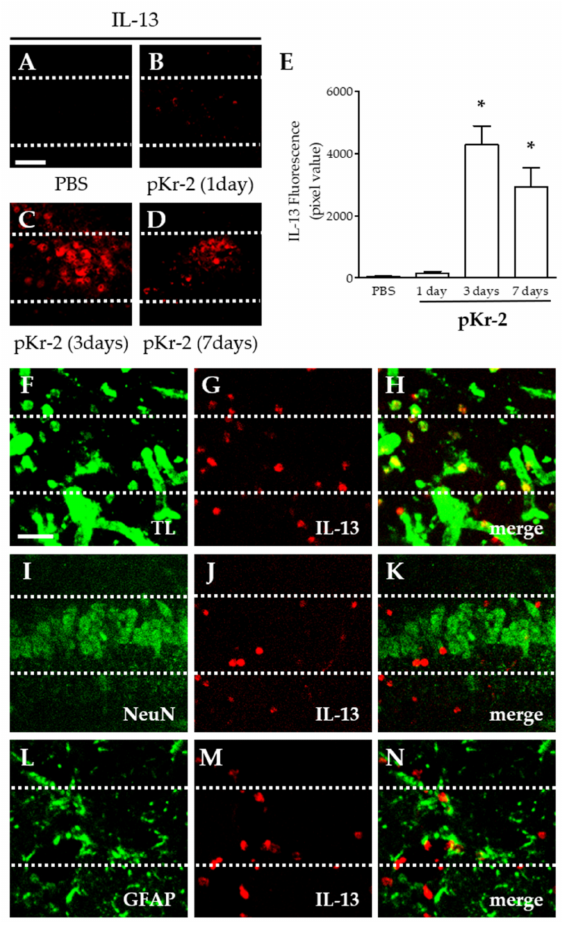
Figure 2. Endogenous expression of IL-13 in the CA1 layer of pKr-2-injected hippocampus in vivo. PBS ( A ) or pKr-2 ( B – D , F – N ) was unilaterally injected into the CA1 layer of rat hippocampi. At in- dicated time points, animals were transcardially perfused and brains were prepared for immuno- histochemical staining. ( A – E ) Immunofluorescence images of endogenous interleukin-13 (IL-13) ( A – D ) and quantification ( E ) in the CA1 layer of rat hippocampus at indicated time points. Scale bar, 40 µ m. * p < 0.001, significantly different from PBS (control). Mean ± SEM; n = 4 to 6 in each group, ANOVA and Newman–Keuls analysis. ( F – N ) Double immunofluorescence images of tomato lectin (TL; F , green) for microglia/macrophages and neutrophils and IL-13 ( G , red) or NeuN ( I , green) for neurons and IL-13 ( J , red) or glial fibrillary acidic protein (GFAP; L , green) for astrocytes and IL-13 ( M , red) and both images are merged (yellow, H , K , N ) in the CA1 layer of hippocampus at 12 h after pKr-2 injection. Scale bar, 25 µ m. These data are representative of four to five animals per group. Dotted lines indicate the CA1 layer of the